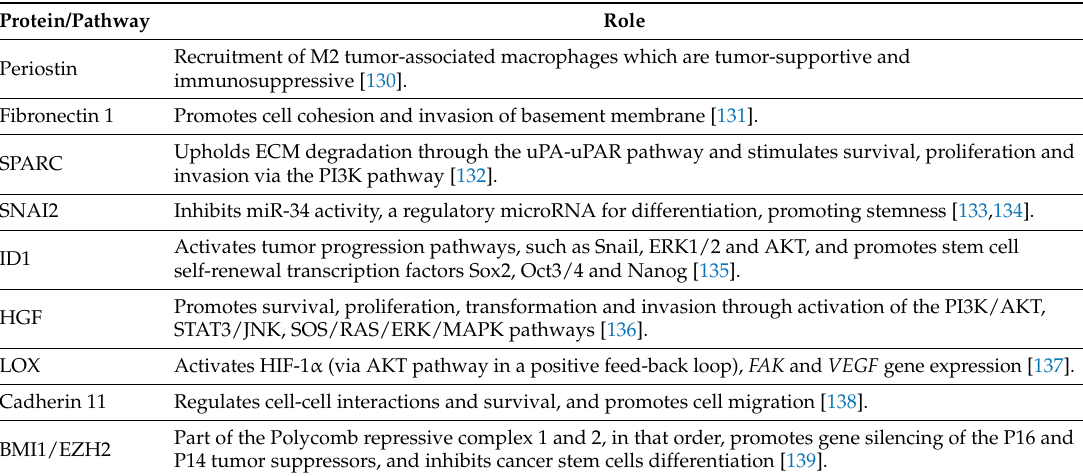
Figure 3. Glioblastoma ZEB1-miRNA-200 feedback loop interactions. In GBM, the ZEB1-miRNA-200 feedback loop targets specific stem cell regulators, namely SOX2, OLIG2, and CD133. ZEB1 up-regulation of c-MYB by the ZEB1-miRNA-200 feedback loop leads to increased expression of the MGMT protein that repairs DNA damage caused by alkylating agents such as temozolomide. ZEB1 positively regulates the ROBO1 protein that has been shown to sever the anchorage of N-cadherin to the cytoskeleton leading to increased GBM cell motility. Table 1. TWIST1 induced pathways and proteins in GBM.